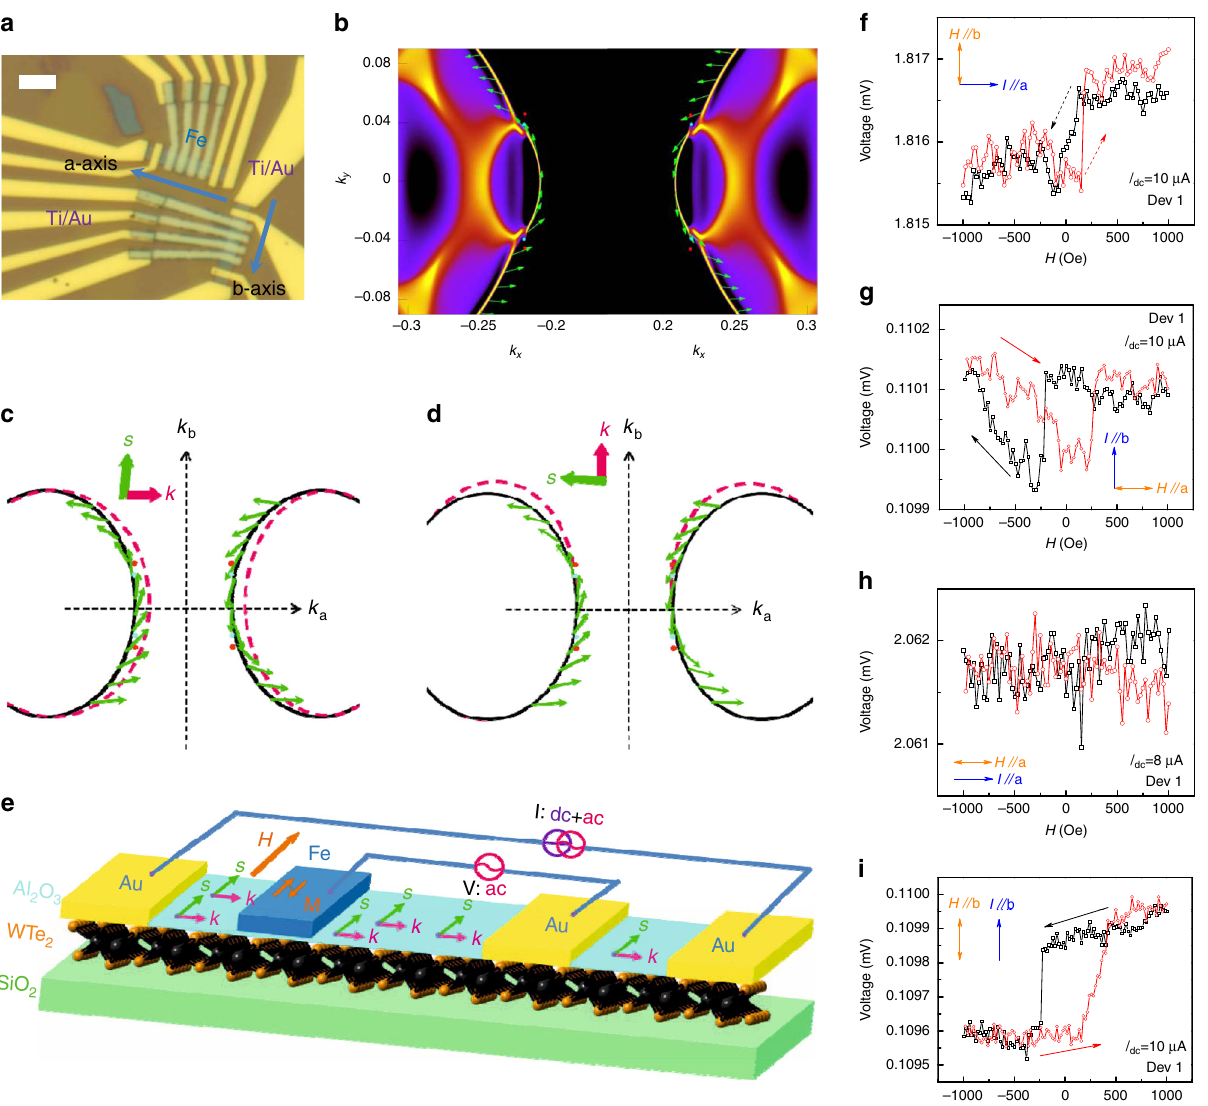
Fig. 2 Spin – momentum locking in WTe 2 /Al 2 O 3 /Fe tunnel junctions. a An optical image of a WTe 2 (14 nm)/Al 2 O 3 (3 nm)/Fe(6nm) tunnel junction device. The arrows indicate the in-plane crystal orientation of WTe 2 . The scale bar is 5 μ m. b A schematic illustration of the relationship between the spin and the momentum of electrons in the surface states in WTe 2 . The red and cyan spots represent the Weyl points with opposite chiralities. The green arrows represent the spin orientation of electrons in surface states. c , d A schematic of spin – momentum locking in the conventional surface states of WTe 2 under different electric fi elds: E // + x and E // + y , respectively. The dashed purple line signi fi es the surface states after applying an electric fi eld. The spins are approximately orthogonal to the momentum. A schematic illustration of the devices and the corresponding measurement con fi guration of the electrical detection of the spin – momentum locking of the surface states in WTe 2 . A DC current of 8 – 50 μ A and an AC current of 1 μ A (lock-in method) were applied during the measurement. Under the application of the DC current, the spin ( s ) of the electrons in the surface states is accumulated, with the direction orthogonal to their momentum ( k ). Therefore, a low resistance is detected when the direction of the magnetic momentum of Fe is parallel to the accumulated spin magnetic moment, and vice versa. The momentum of the ferromagnetic layer is switched by an in-plane magnetic fi eld. f – i The voltage measured across two inner electrodes for the tunnel junction (WTe 2 /Al 2 O 3 /Fe) as a function of in-plane magnetic fi eld. The con fi gurations between the DC current direction and the magnetic fi eld direction are indicated in the fi gures ( T = 2 K). The con fi gurations in different panels are f : I dc // a ( I dc = 8 μ A), H// b ; g : I dc // b ( I dc = 10 μ A) , H// a ; h : I dc // a ( I dc = 10 μ A), H// a ; and i : I dc // b ( I dc = 10 μ A), H// b . The thickness of the WTe 2 in this device (Device 1)